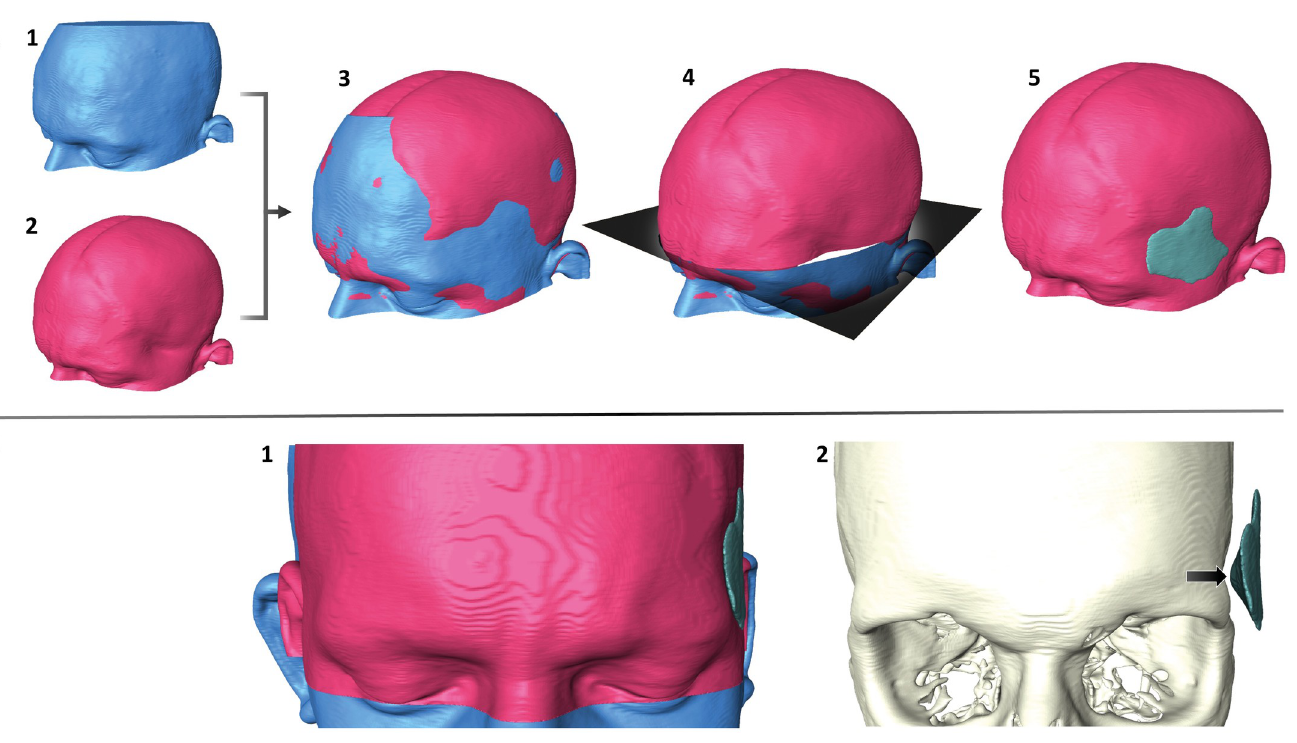
PLOS ONE | https://doi.org/10.1371/journal.pone.0258776 October 19,